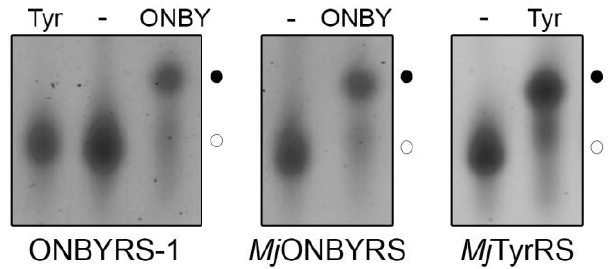
Figure 4. ONBY serves as a substrate of ONBYRS-1 and Mj ONBYRS. Representative in vitro aminoacylation of Mj tRNA CUA by ONBYRS-1 (44 ± 8%, n = 6, left panel) and Mj ONBYRS (42 ± 9%, n = 10, middle panel) with ONBY, as well as by Mj TyrRS with Tyr (48 ± 12%, n = 15, right panel) analyzed by gel electrophoresis. In vitro transcribed, uncharged tRNA served as a control (-). ONBYRS-1 does not aminoacylate tRNA CUA with tyrosine (Tyr, left panel). Aminoacyl-tRNAs (●) were detected by their slower migration compared to uncharged tRNA ( ○ ) in 6.5% acidic denaturing PAGE. tRNAs were visualized by SYBR gold staining.